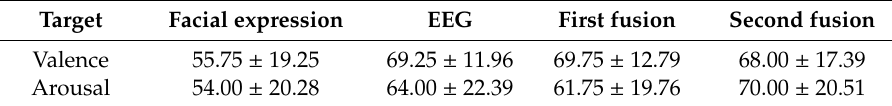
Table 3. Emotion recognition accuracy for the online experiment.